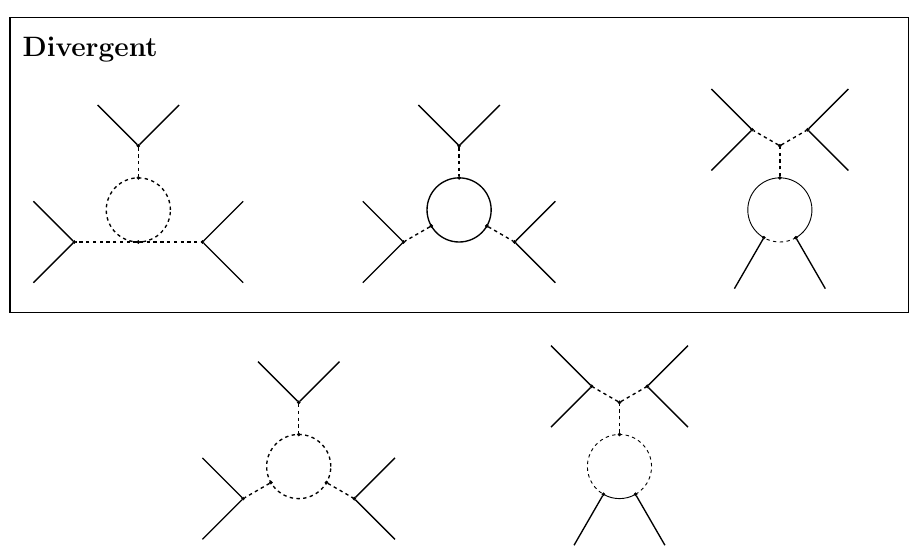
Figure 16 . Non-genuine one-loop diagrams which correspond to the one-loop generation of one of the couplings in the tree-level diagram N-0-1-1 (see figure 2). The diagrams in the box are